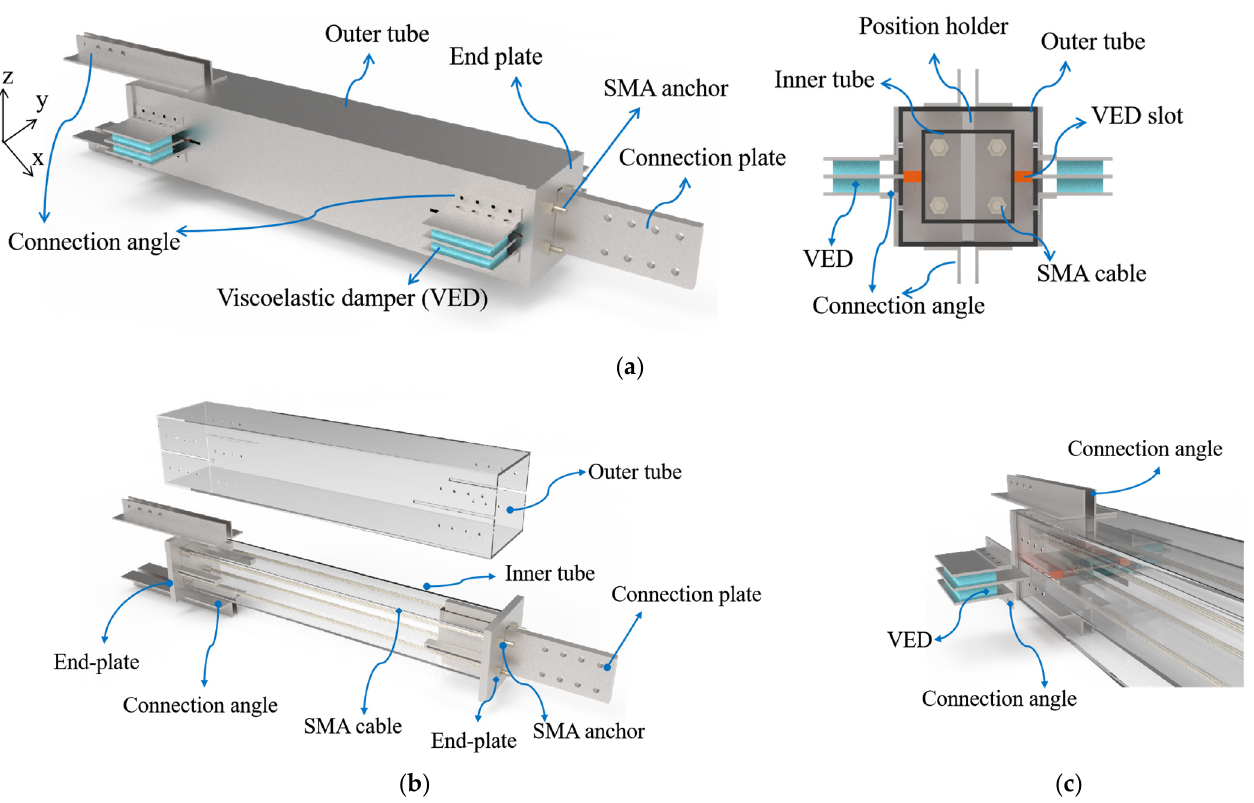
Figure 1. Three-dimensional schematic illustration of ( a ) SMA-viscoelastic hybrid braces (SCVEB), as well as its ( b ) self-centering (SC) system and ( c ) energy-dissipation (ED) system.